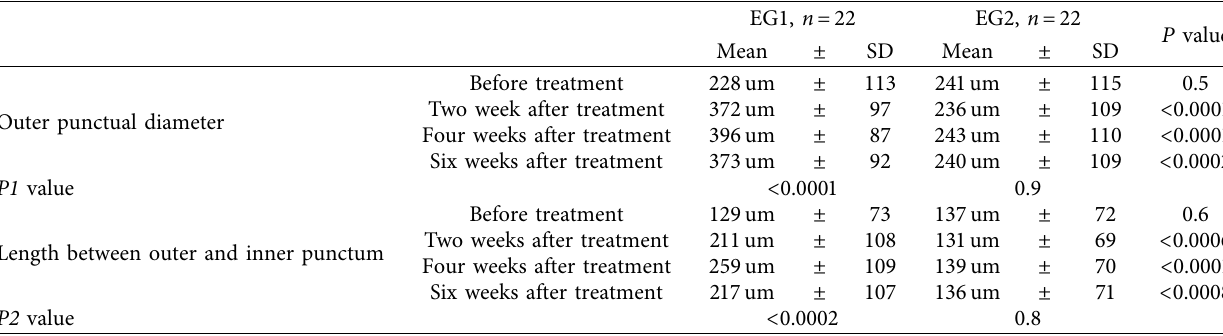
Table 2: Outer punctual diameter and length between the outer and inner punctum of both groups during follow-up period of six weeks.